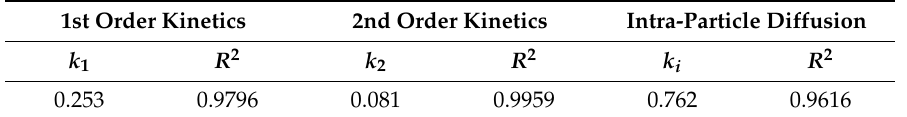
Figure 7. ( A ) pseudo first order, ( B ) pseudo second order and ( C ) intra-particle diffusion kinetic plots for adsorption of dye at LNT4 NPs surface. Table 4. Adsorption kinetics parameter obtained from adsorption of MB dye at surface of LNT4 NPs.